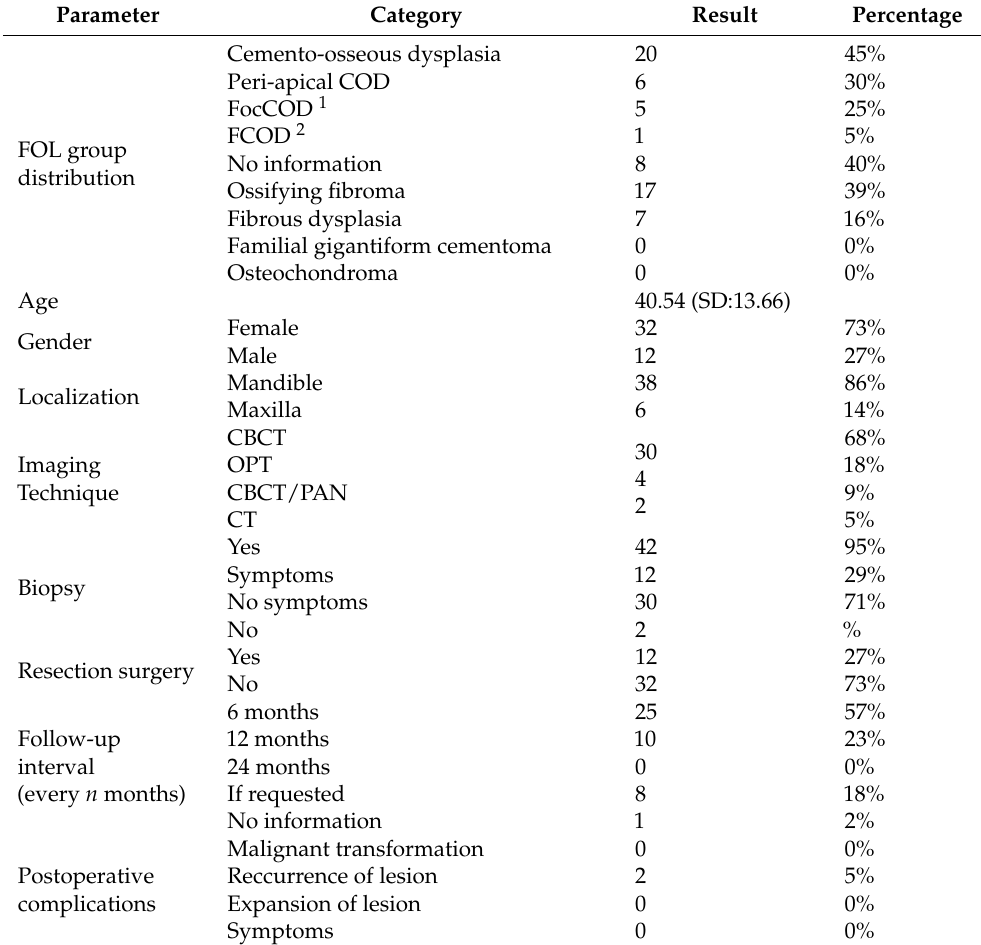
Table 1. Overview: Demographic, clinical, radiological, and pathological parameters for all fibro- osseous